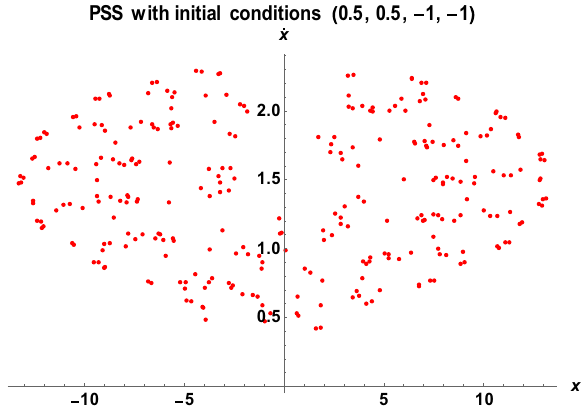
Figure 16. The PSS for the Earth–Moon system with µ = 0.01215, A = 0.0000003686, e = 0.0549, a = 1.000453, T = 0.01, σ 1 = 0.30, σ 2 = 0.006, α = 0.06, k = 6, M b = 0.06 .